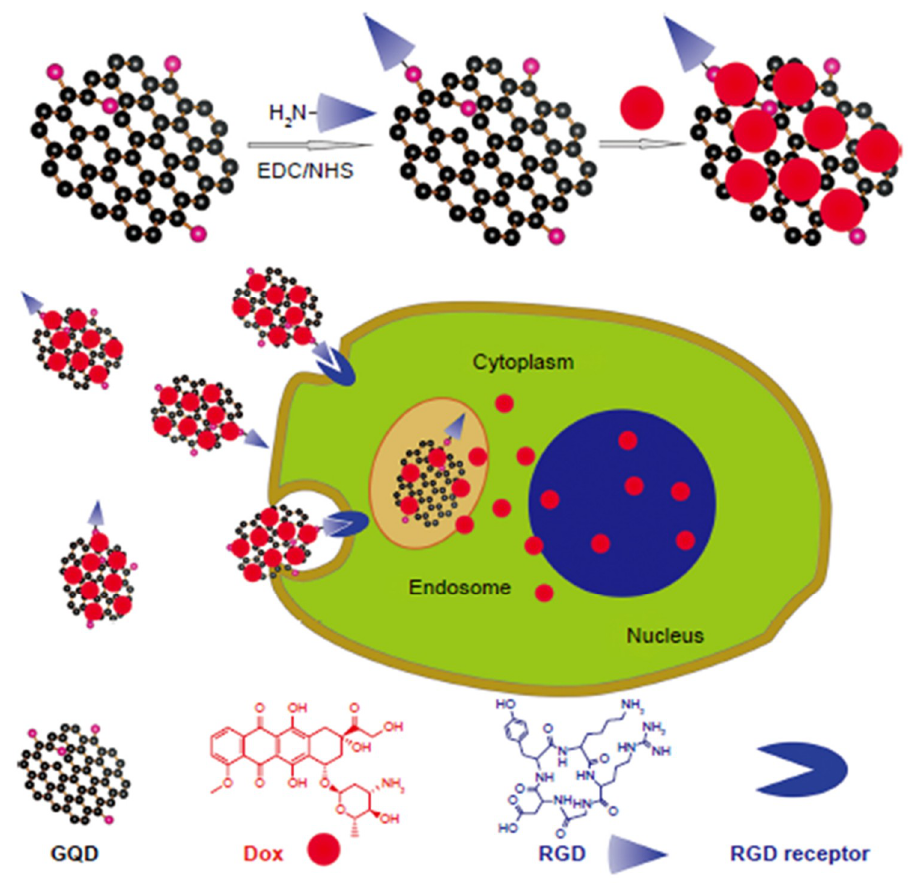
Figure 10. Schematic representation of multifunctional GQD‐based DDS for the targeted delivery of DOX and their interactions with prostate cancer cells [166]. DOX, doxorubicin; RGD, arginine‐glycine‐ aspartic acid; EDC/NHS, 1‐(3‐(dimethylamino)propyl)‐3‐ethylcarbodiimide and N‐hydroxysuccinimide.